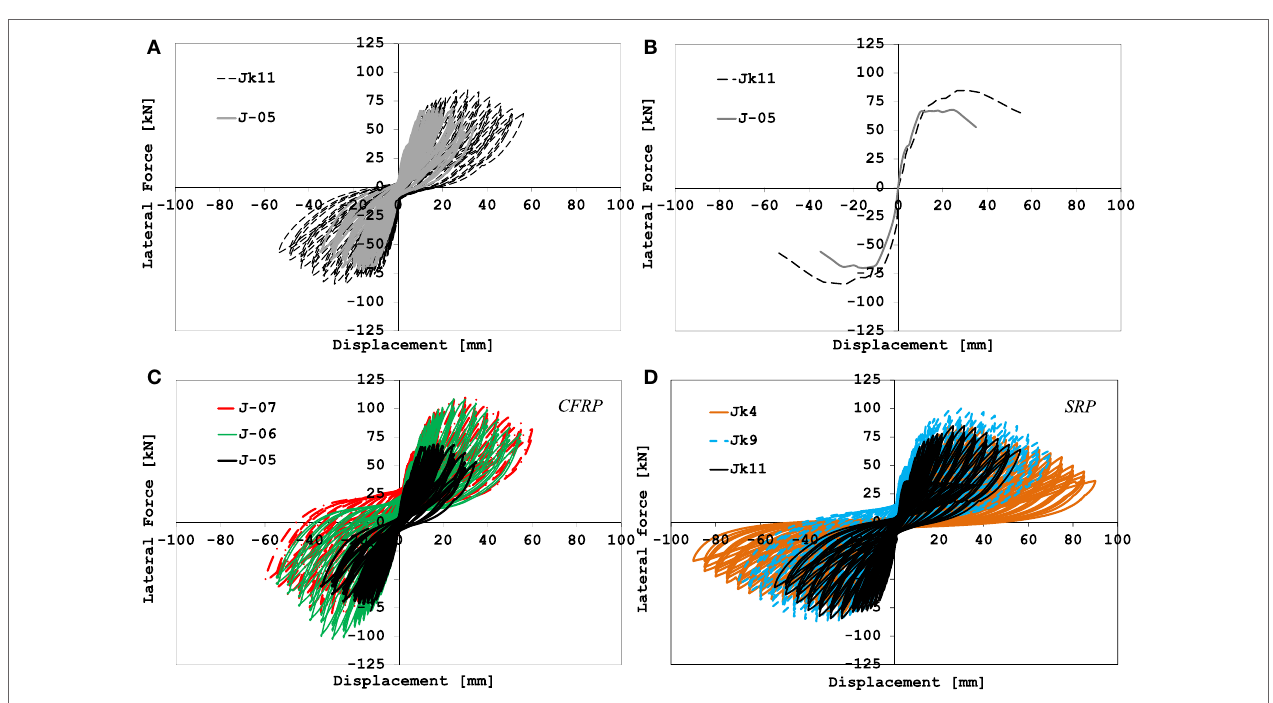
FIGURE 9 | Load-displacement curves for: control specimens (A,B) ; CFRP strengthened specimens (C) ; SRP strengthened specimens (D) .